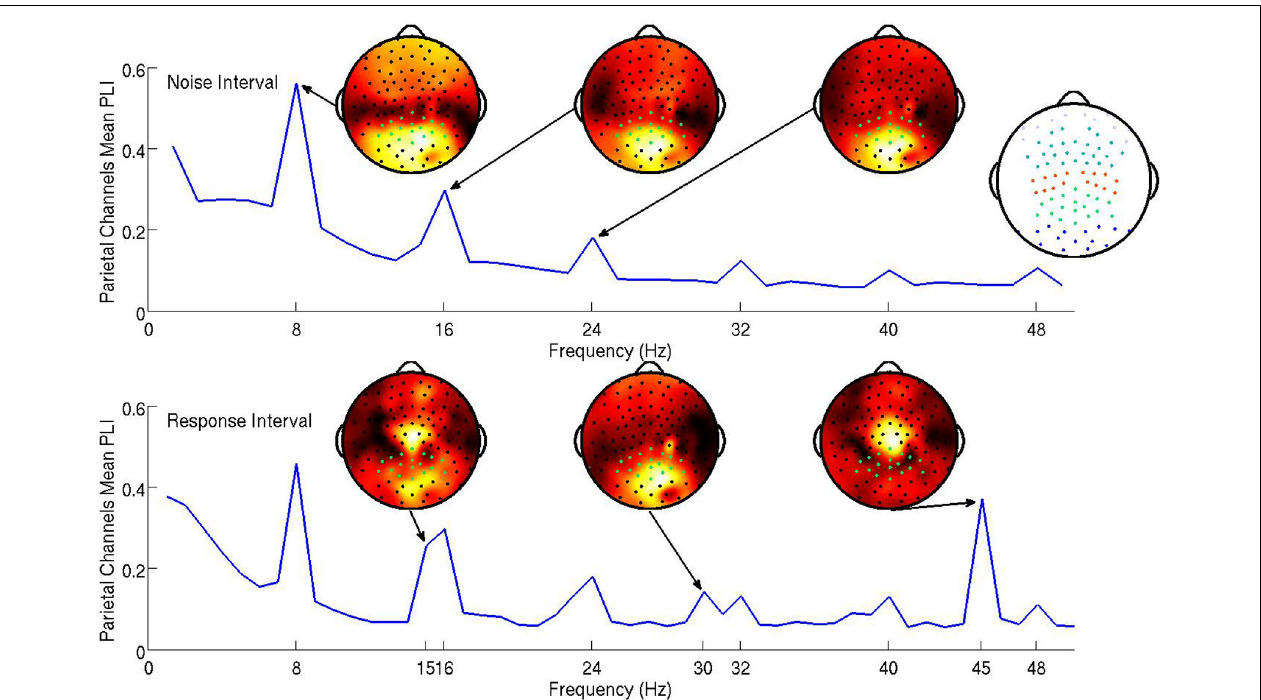
FIGURE 3 | The subject mean parietal channel PLI at all frequencies in the noise interval (top panel) and the response interval (bottom). The resolution of the the PLI spectra in the top plot is approximately 1 . 3Hz due to the PLI being a function of Fourier transforms of 750ms epochs. The resolution of the PLI spectra in the bottom plot is 1Hz as the Fourier transforms are of 1000ms epochs. The 15 and 16 steady-state responses during the response interval are separable when using 1000ms epochs. Also shown are subject mean PLI topographies (at 8, 16, and 24Hz during the